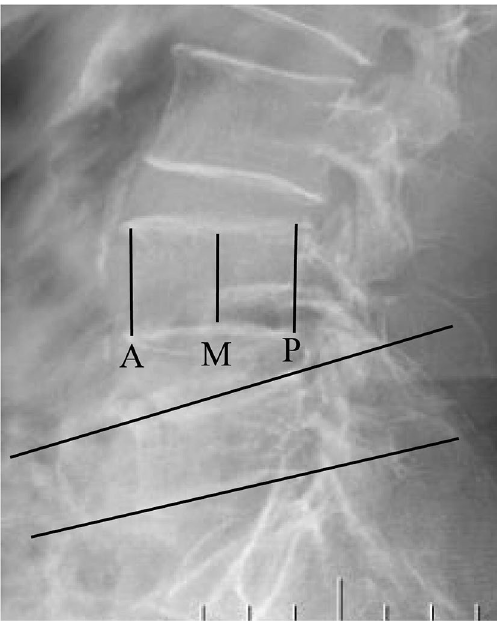
Figure 4. The local Cobb angle was measured to determine the kyphotic deformity on lateral radiographs. A, M and P represented anterior, middle and posterior height of vertebral body, respectively. The height of the fractured vertebral body was assessed via the compression ratio before and after operation, the compression ratio was computed by A/P × 100% and M/P ×